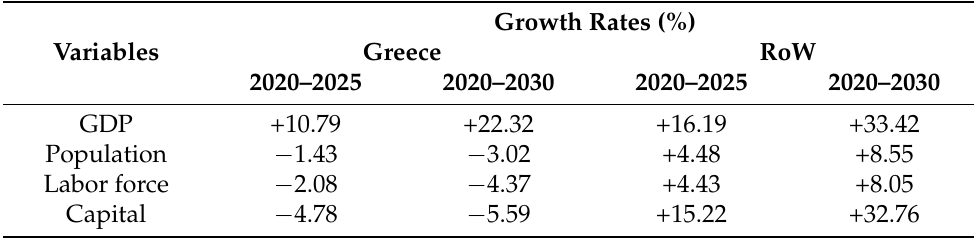
Table 3. Baseline growth rates provided as shocks to Global Trade Analysis Project (GTAP) for constructing the Business as Usual (BAU) scenarios of Greece and Rest of World (RoW) over the